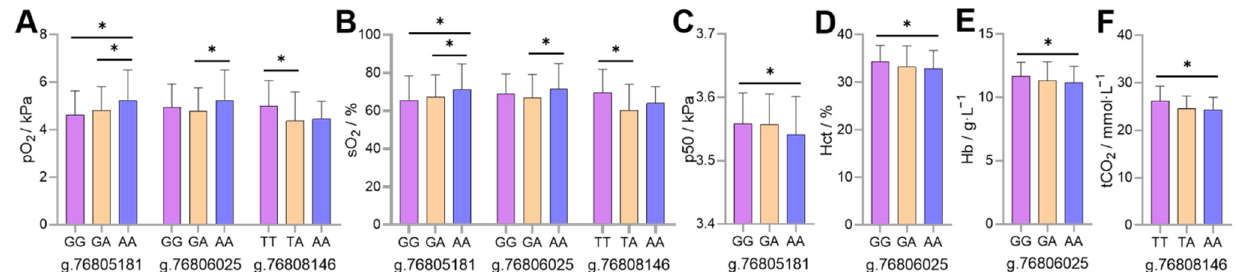
Figure 5. Association analysis of genotype at the g.76805181, g.76806025 and g.76808146 positions saturation oxygen partial pressure (p50) ( C ), hematocrit (Hct) ( D ), hemoglobin (Hb) concentration